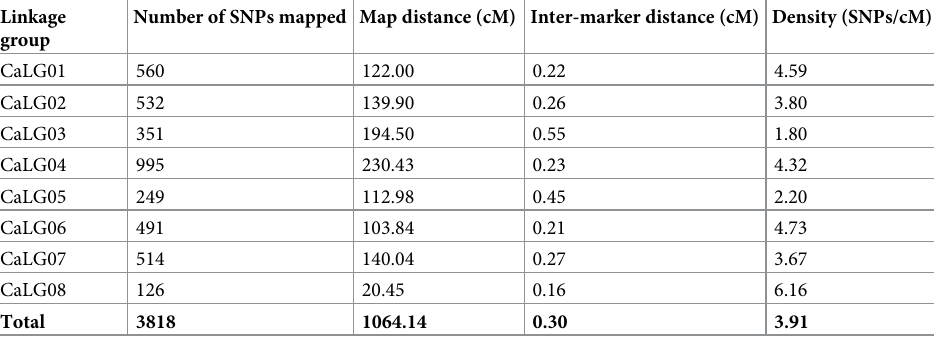
Table 2. Summary of the genetic map constructed for ICC 4958 × DCP 92–3 RIL population using Axiom 1 Ci- cerSNP